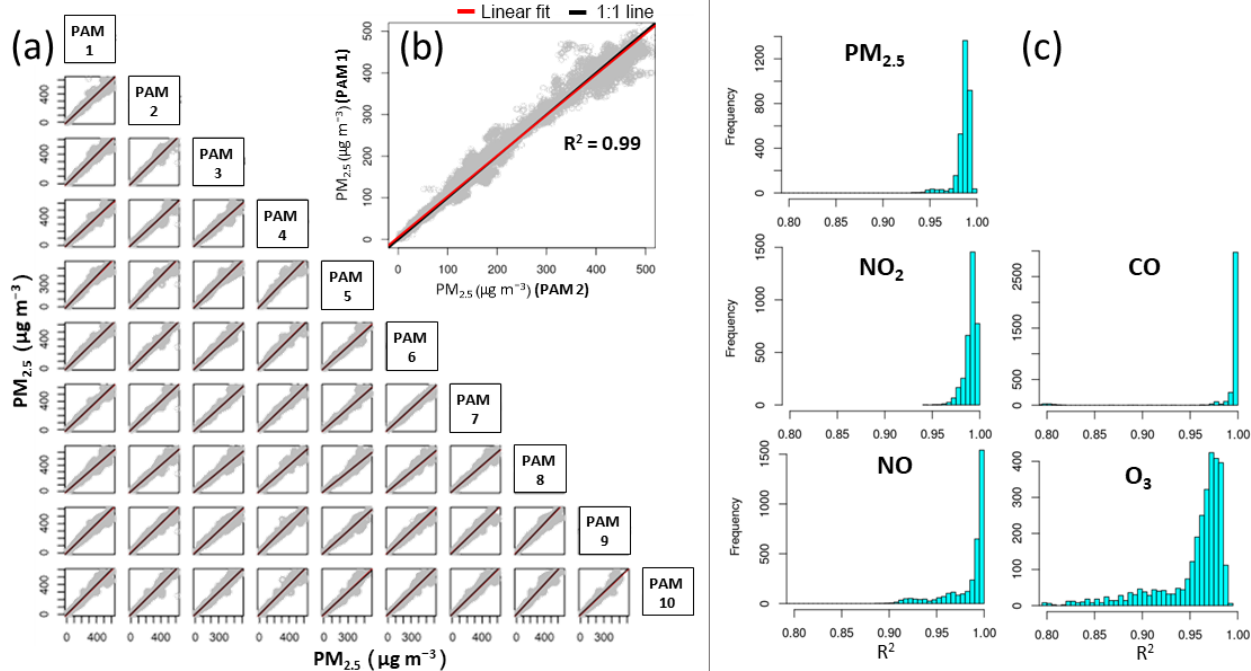
Figure 2. Reproducibility of a PAM network (in that case 60 monitors) co-located outdoors in Beijing during the heating season after 1 month of field deployment. (a) Scatterplot of the PM 2 . 5 measurements between 10 sensor pairs. The 1:1 line is in black, and the linear fit line is in red. (b) Close-up of a scatterplot from (a) of one representative sensor pair. (c) Histogram of the coefficient of determination ( R 2 ) between all sensor pairs. R 2 values during this deployment were higher than 0.90 for all pollutants indicating the high reproducibility of the sensors’ readings (see Table S1 for all co-locations). O 3 sensors R 2 > 0 . 80 due to very low ambient levels close to the LOD of the sensors. Table 2. Details of the reference instruments used in this study. Time resolution of all measurements was